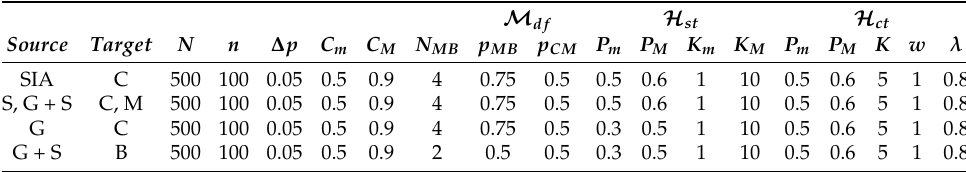
Table 2. Hyper-parameters of our method (Section 3 and Algorithms 1–3). Datasets: GTAV (G), Synscapes (S), SYNTHIA (SIA), Cityscapes (C), BDD100K (B), Mapillary Vistas (M). M df H st H ct Source